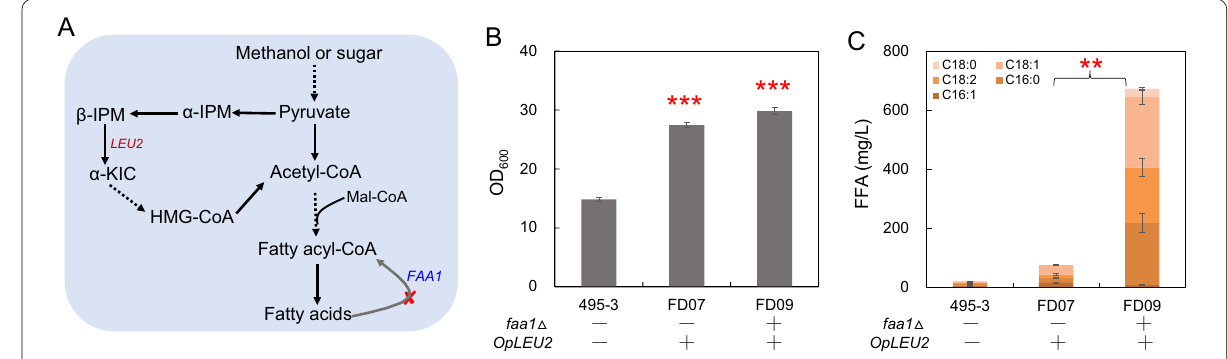
Fig. 1 Fatty acids production from glucose in engineered O. polymorpha . A Schematic diagram of FFA synthesis pathway and leucine (LEU) metabolism in O. polymorpha . Deletion of fatty acyl-CoA synthetase (encoded by FAA1 ) may block the β-oxidation of FFA, which eventually result in FFA accumulation. α-IPM: α-isopropyl malic acid, β-IPM: β-isopropyl malic acid, α-KIC: α-Ketoisocaproic acid, HMG-CoA: Hydroxymeglutaryl-CoA. B Cell growth of O. polymorpha strains with integrated OpLEU2 in situ and disrupted FAA1 . C FFA titers of O. polymorpha strains with integrated OpLEU2 in situ and disrupted FAA1 . The fermentation was carried out in minimal medium containing 20 g/L glucose at 37 °C 220 rpm for 96 h. Data are presented as mean s.e.m. (n 3 biologically independent samples). Red asterisks indicate statistical significance as determined by paired t test ± = (**P < 0.01; ***P <